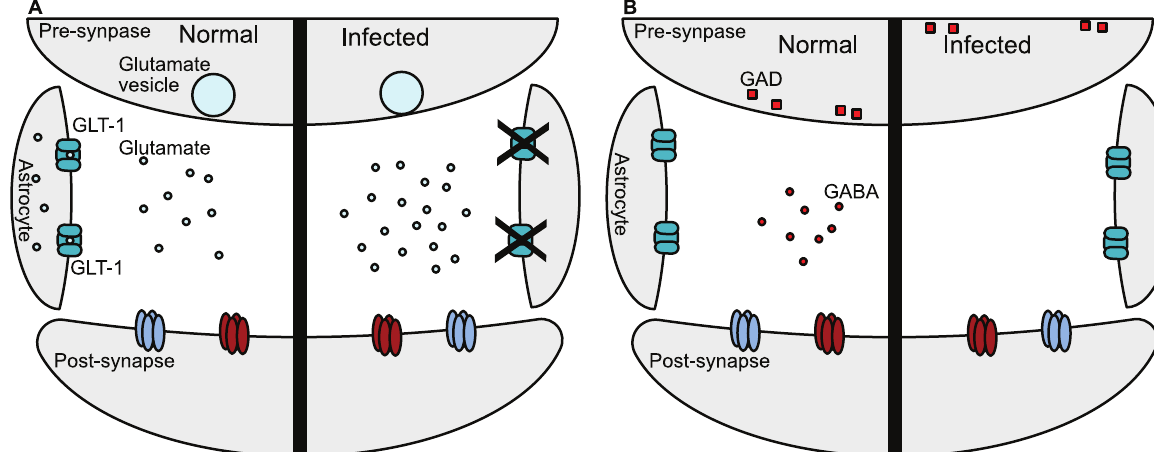
Fig 3. Schematic of Toxoplasma gondii effects on glutamate and glutamate decarboxylase. (A) Under normal conditions, glutamate, an excitatory neurotransmitter, is released into the synaptic cleft from the presynaptic neuron. Glutamate then diffuses across the synaptic cleft to act on glutamatereceptors on the postsynaptic neuron, leadingto excitationof the postsynapticneuron. This glutamatergicsignalingis terminated by uptake and recyclingof synaptic glutamateby the glutamatetransporter GLT-1 on surrounding astrocytes. Glutamate uptake by GLT-1 is essentialto avoid excessiveglutamate signaling, which can lead to postsynaptic excitotoxicity and neuronaldeath. After an infection, GLT-1–dependent transport into astrocytes is impaired,allowingfor an increasein glutamate accumulationin the synaptic cleft, which is expectedto lead to more excitationof the postsynaptic neuron. (B) Glutamate decarboxylase (GAD) is primarily found on presynaptic terminals, where it will process glutamateinto γ -aminobutyric acid (GABA), the major inhibitory neurotransmitter in the brain. Once GABA is releasedinto the synapticcleft, it will bind onto GABA receptors on the postsynaptic neuron, which decreases the excitabilityof the postsynaptic neuron. In the case of infection, GAD is redistributedinto the cytosol of the presynapticneuron, which would be expected to cause improperGABA localization at synapses, leadingto decreased inhibitionof the postsynapticneuron.